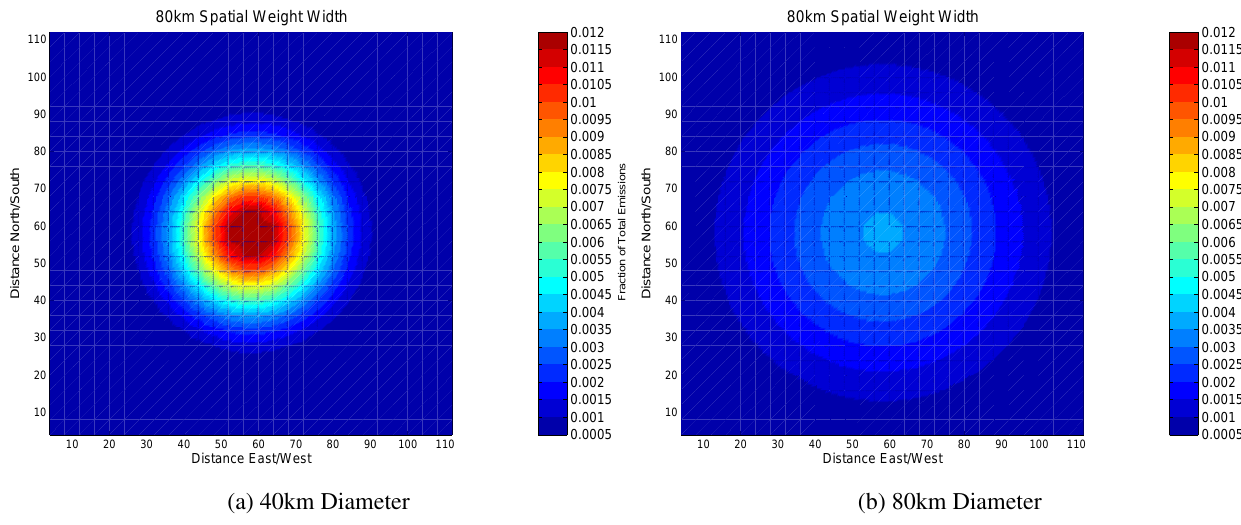
Fig. 4. Example of how the geospatial weighting of emissions impacts the distribution of urban emissions, for two example cases. Frame (a) corresponds to a gaussian standard diameter of 40km and frame (b) to a gaussian standard diameter of 80km. The color scale is identical for both plots.